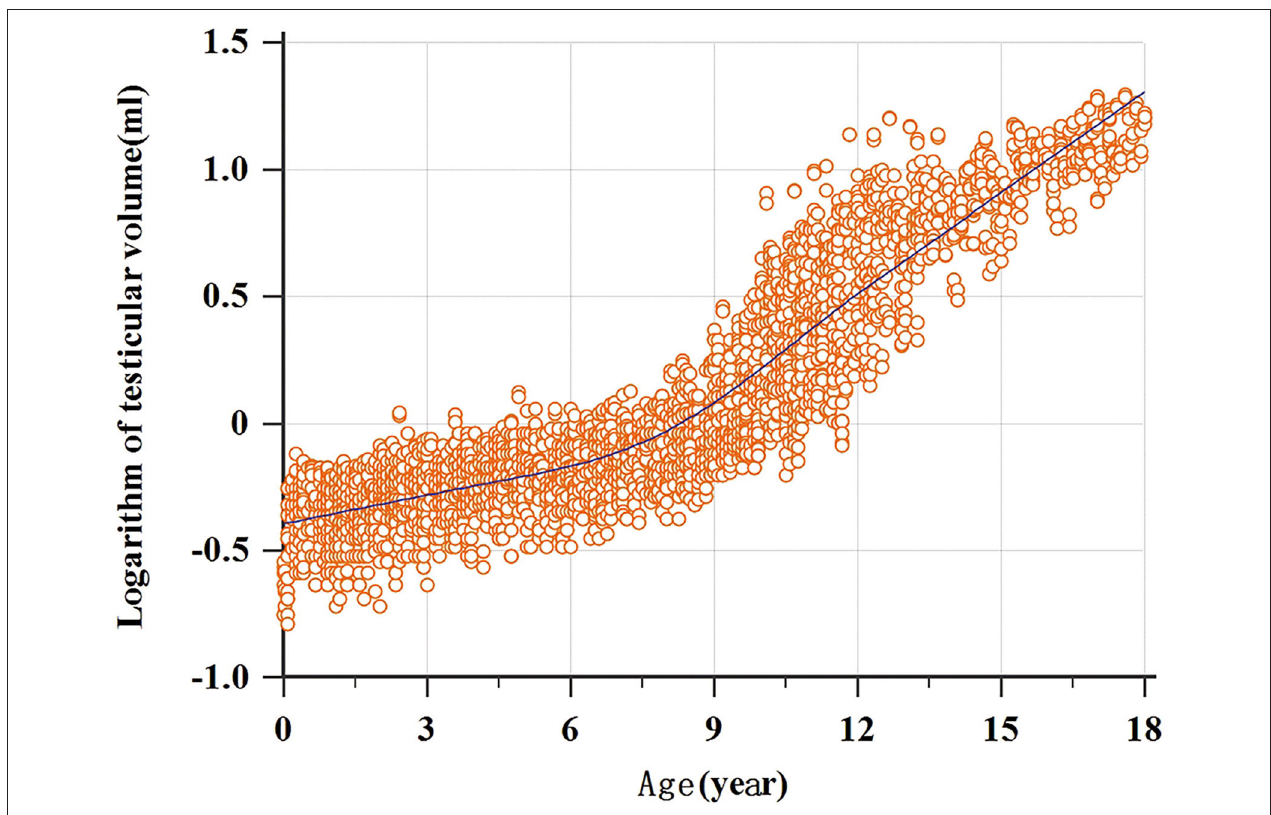
FIGURE 3 | Scatter diagram by using logarithmic transformation of testicular